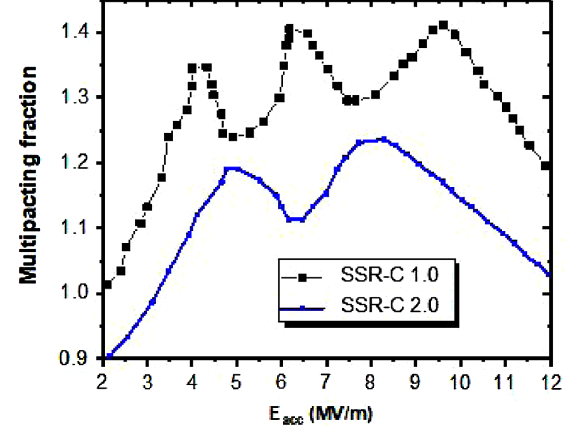
FIG. 32. Multipacting yield as a function of accelerating gradient before (model-1) and after (model-2) introduction of the double corner radius.